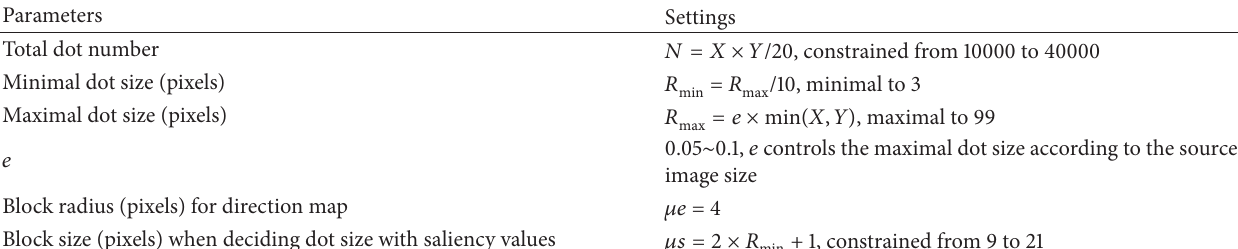
Table 1: Pointillism settings.